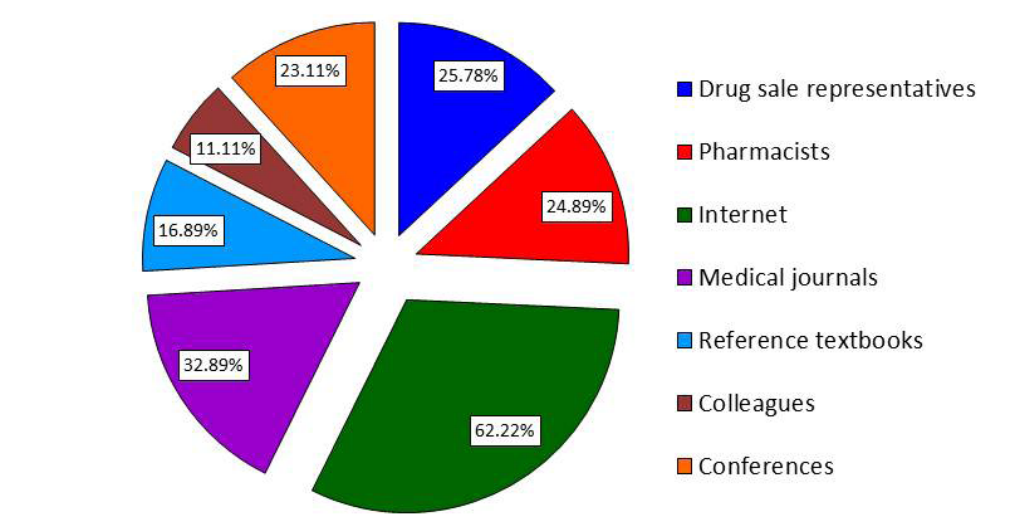
FIGURE 3 - Hospital prescribers’ sources of information on new